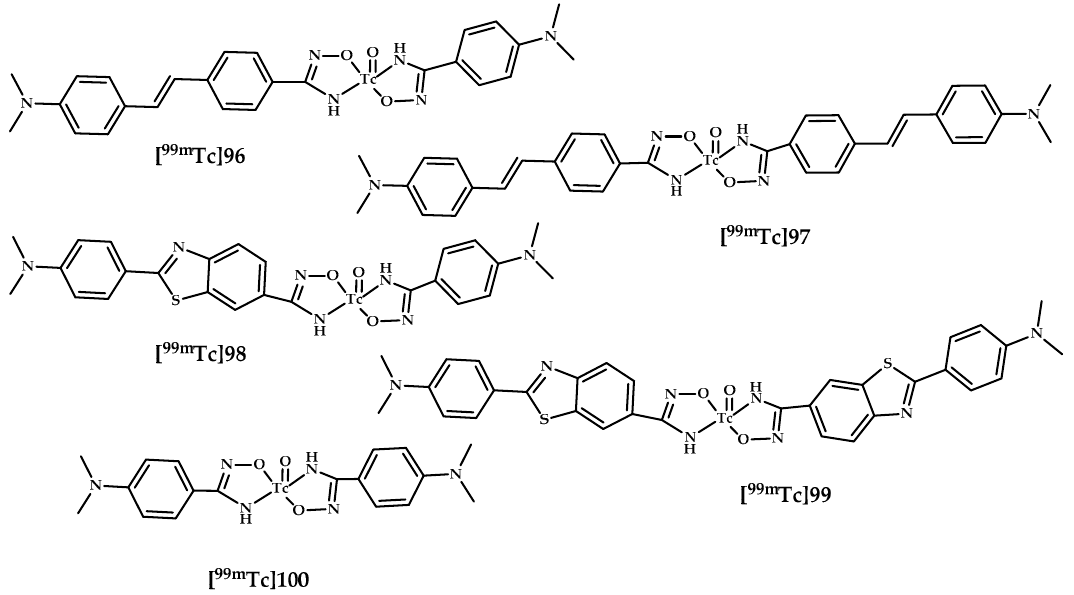
Figure 24. 99m Tc–HAM complexes based on stilbene and benzothiazole moieties [ 99m Tc]96–99 , designed for SPECT imaging of A β plaques, and model coordination compound 100 . for SPECT imaging of A β plaques, and model coordination compound 100